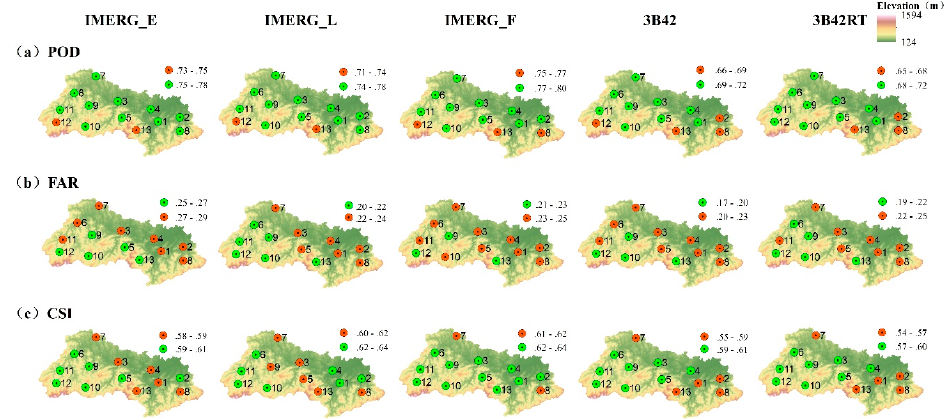
Figure A5. Spatial distribution of the annual categorical evaluation metrics at daily scale: ( a ) POD ; ( b ) FAR ; and ( c ) CSI .